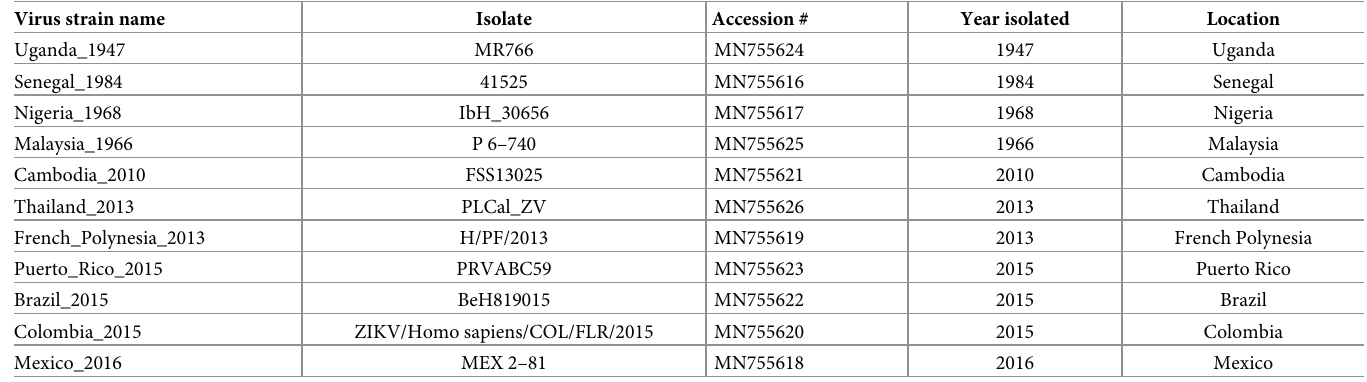
Virus strain name